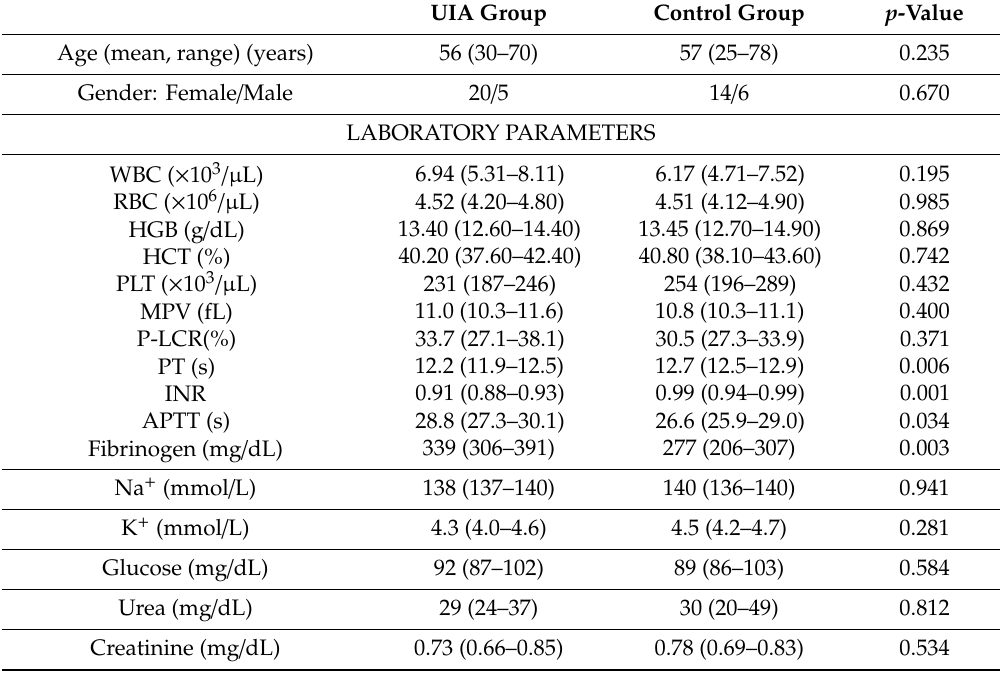
Table 1. Characteristics of unruptured intracranial aneurysm (UIA) patients and control individuals. Results are presented as median with 25th and 75th percentiles. The p -value of < 0.05 is considered statistically